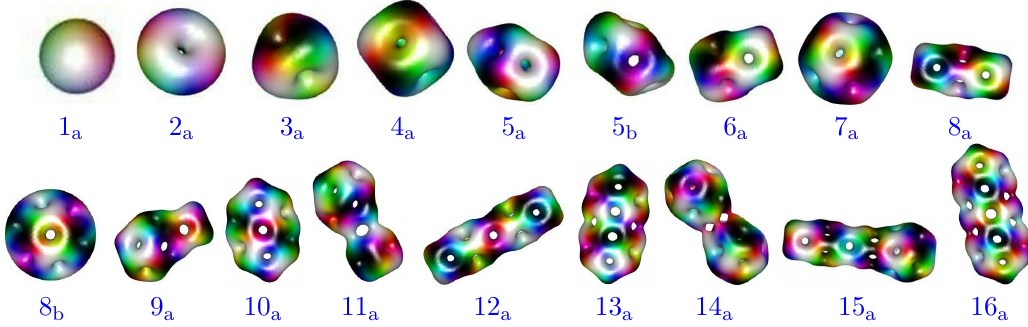
Figure 2. Minimizers of the Skyrme model with pion mass m = 1 . The appearance of more than one Skyrmion with same baryon number indicates close lying states, with increasing energy as the alphabet increases, but whose energies are within the estimated systematic